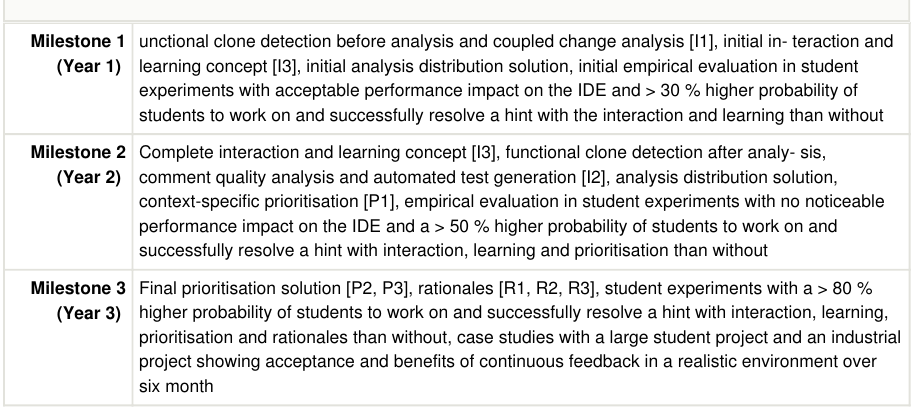
Milestones and success criteria (with corresponding objectives in square